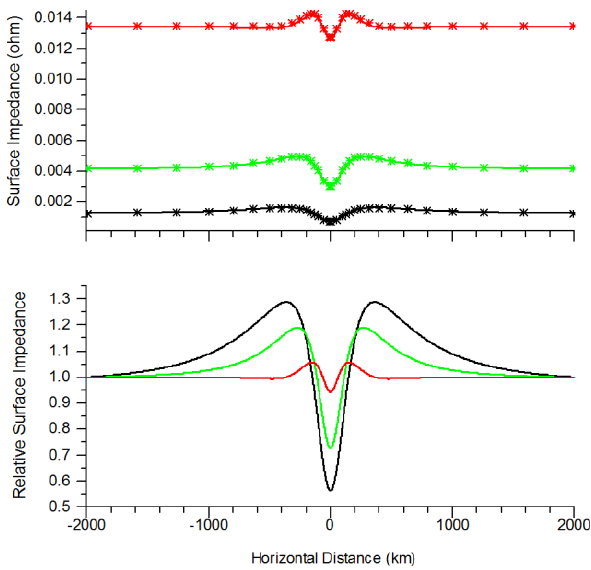
Fig. 5. The magnitude of surface impedance for the layered earth conductivity model of Quebec is shown for three different periods (red 30s, green 300s, and black 1800s). The FEM results are the solid curves whereas the FHT results are symbols. The lower graph shows the relative impedance based on FEM where each value is normalized by the value at x = −2000 km.